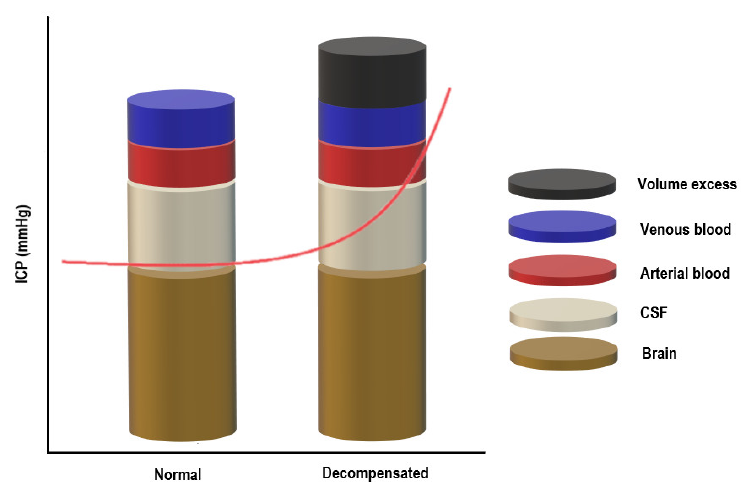
Figure 1. The Monro–Kellie doctrine.